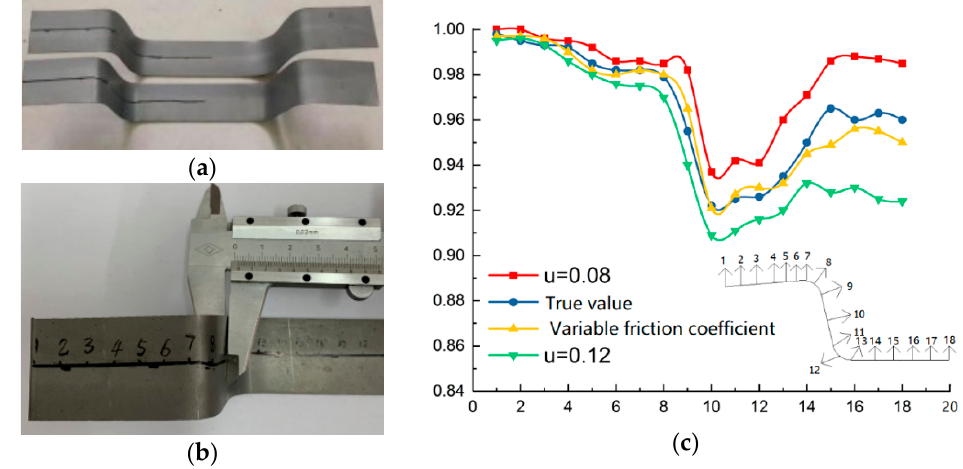
Figure 11. Friction coefficient curve under different loads and function fitting curve: ( a ) Warming stamping mold; ( b ) U-bend parts and thickness measurement; ( c ) Thickness distribution curve under different conditions.